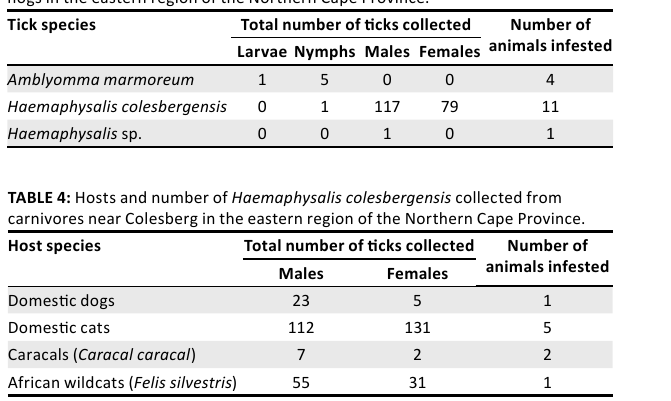
animals infestedLarvae Nymphs Males Females